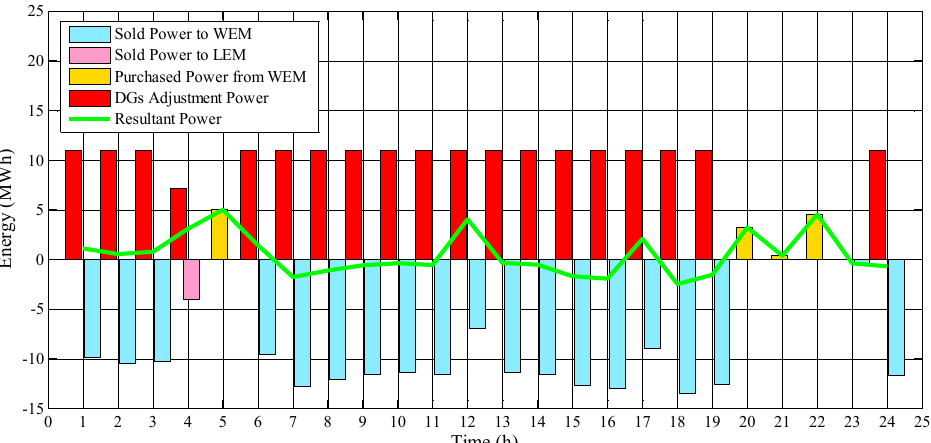
Figure 15. DSO’s traded energy in the RT markets for scenario 6 considering the competitive environment.